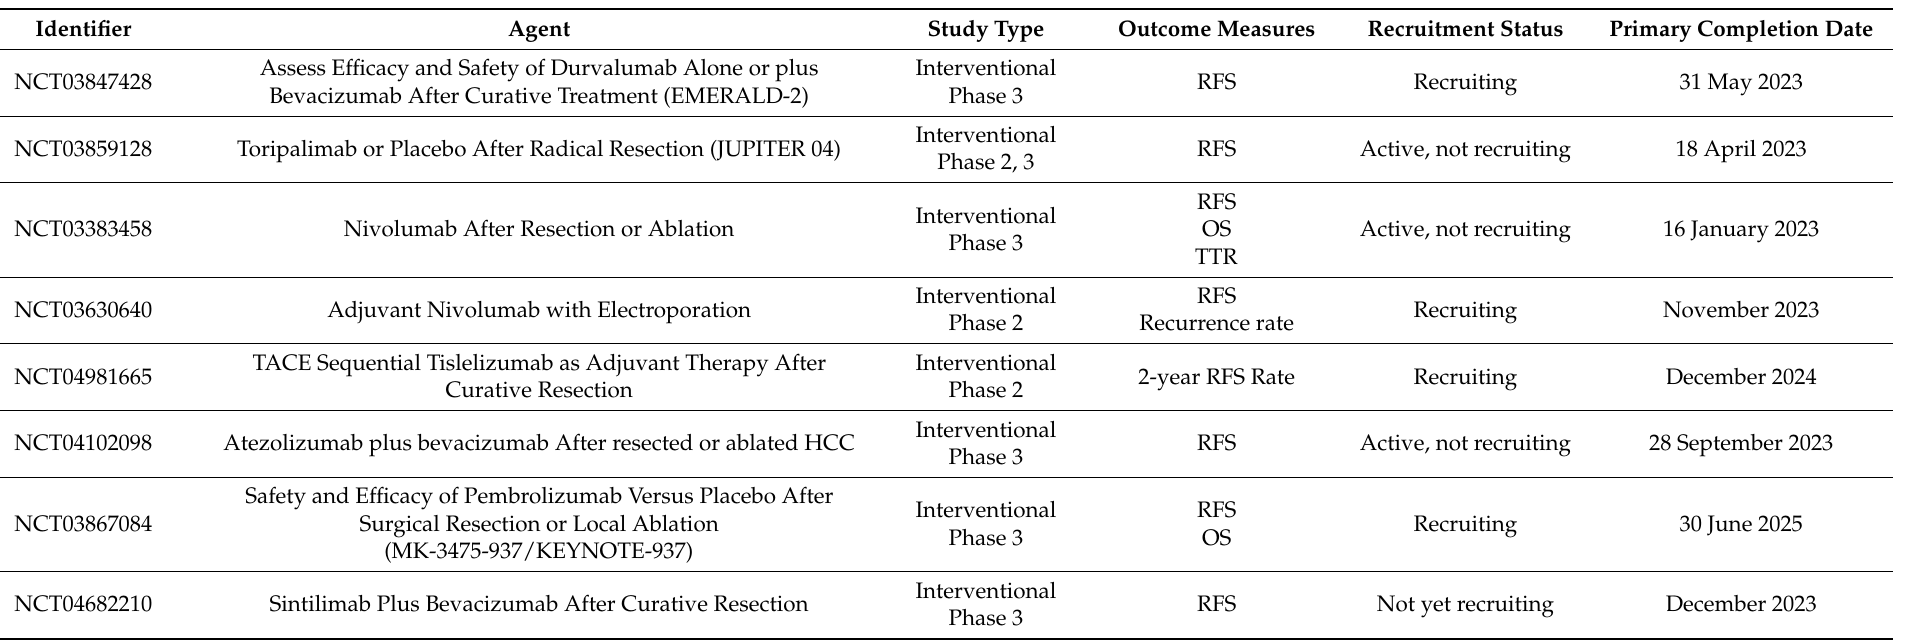
Table 2. Ongoing studies of adjuvant therapies investigating the combination of ICIs and curative